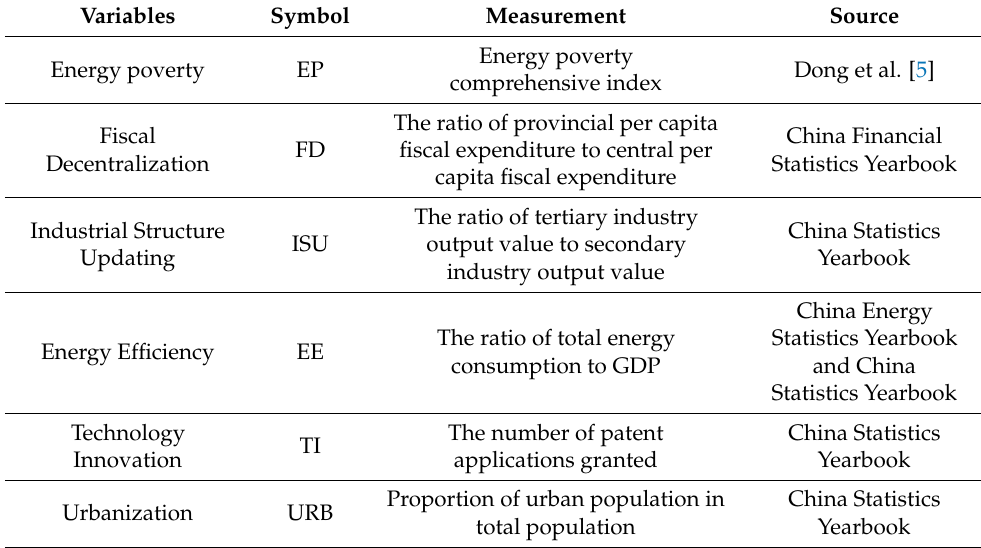
Table A1. Variable’s